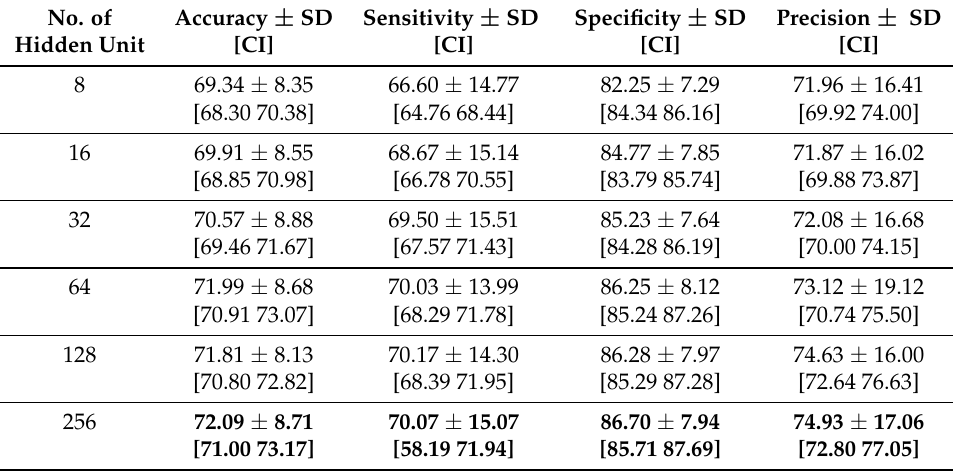
Table 5. Accuracy, Sensitivity, Specificity and Precision for Various Number of Hidden Unit Using LSTM. (The Numbers in Bold Indicate the Best Value Obtained for Each Quality